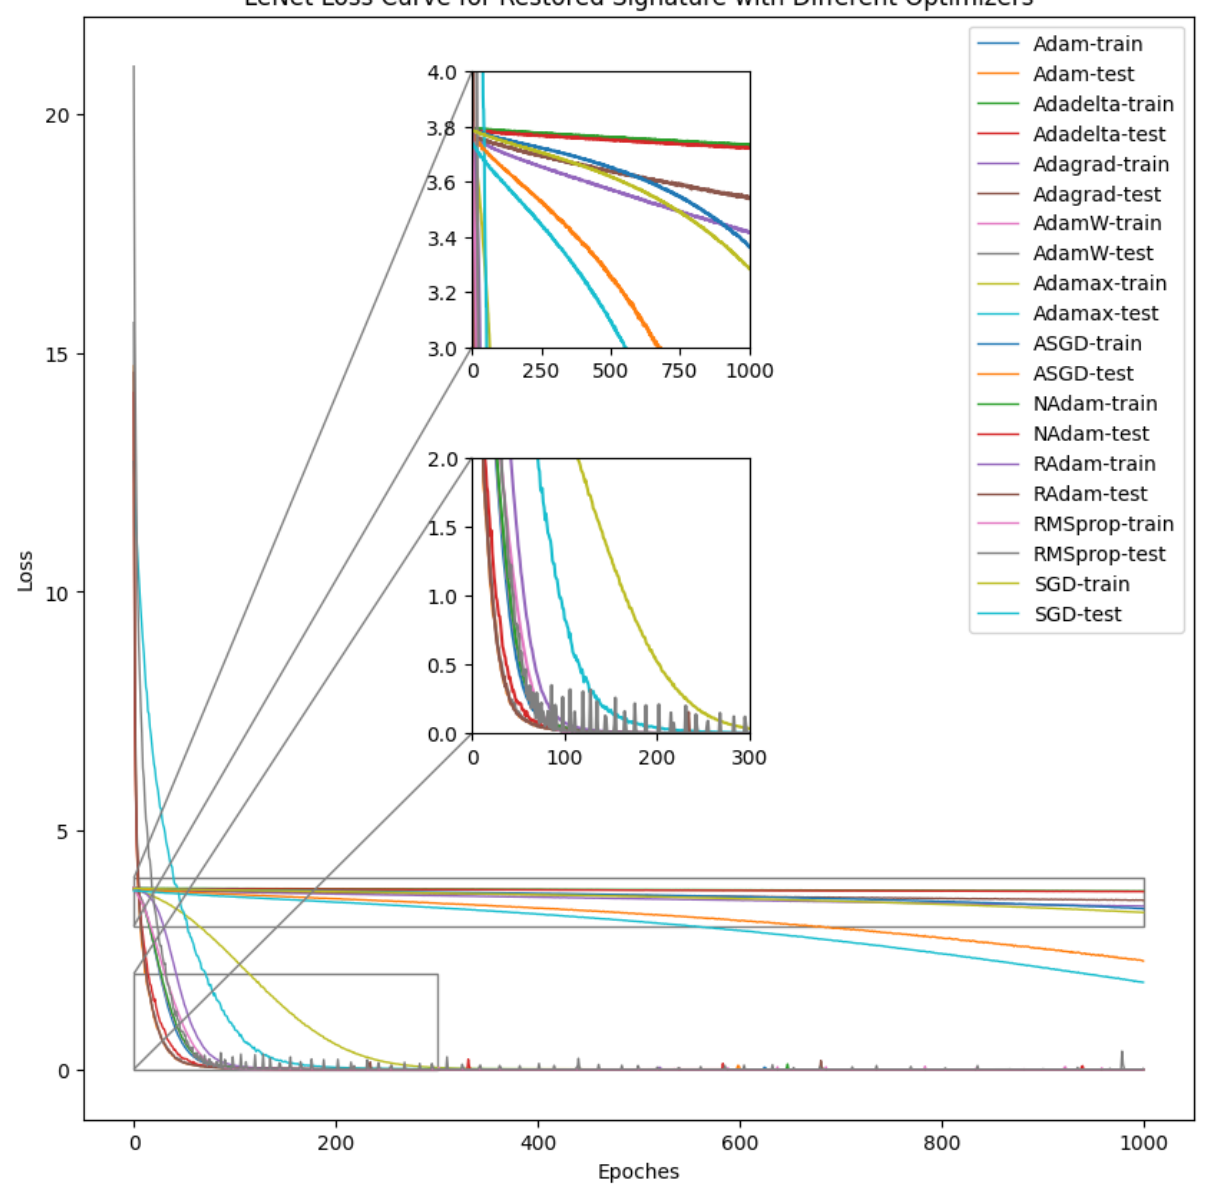
Figure 11. The loss curve of LeNet with respect to 10 different optimizers. Both the learning loss and testing loss for each optimizer are covered in the graph. The two zoom-in areas are ( x 1 , x 2 ) = (0, 1000), ( y 1 , y 2 ) = (3, 4); ( x 1 , x 2 ) = (0, 300), ( y 1 , y 2 ) = (0,